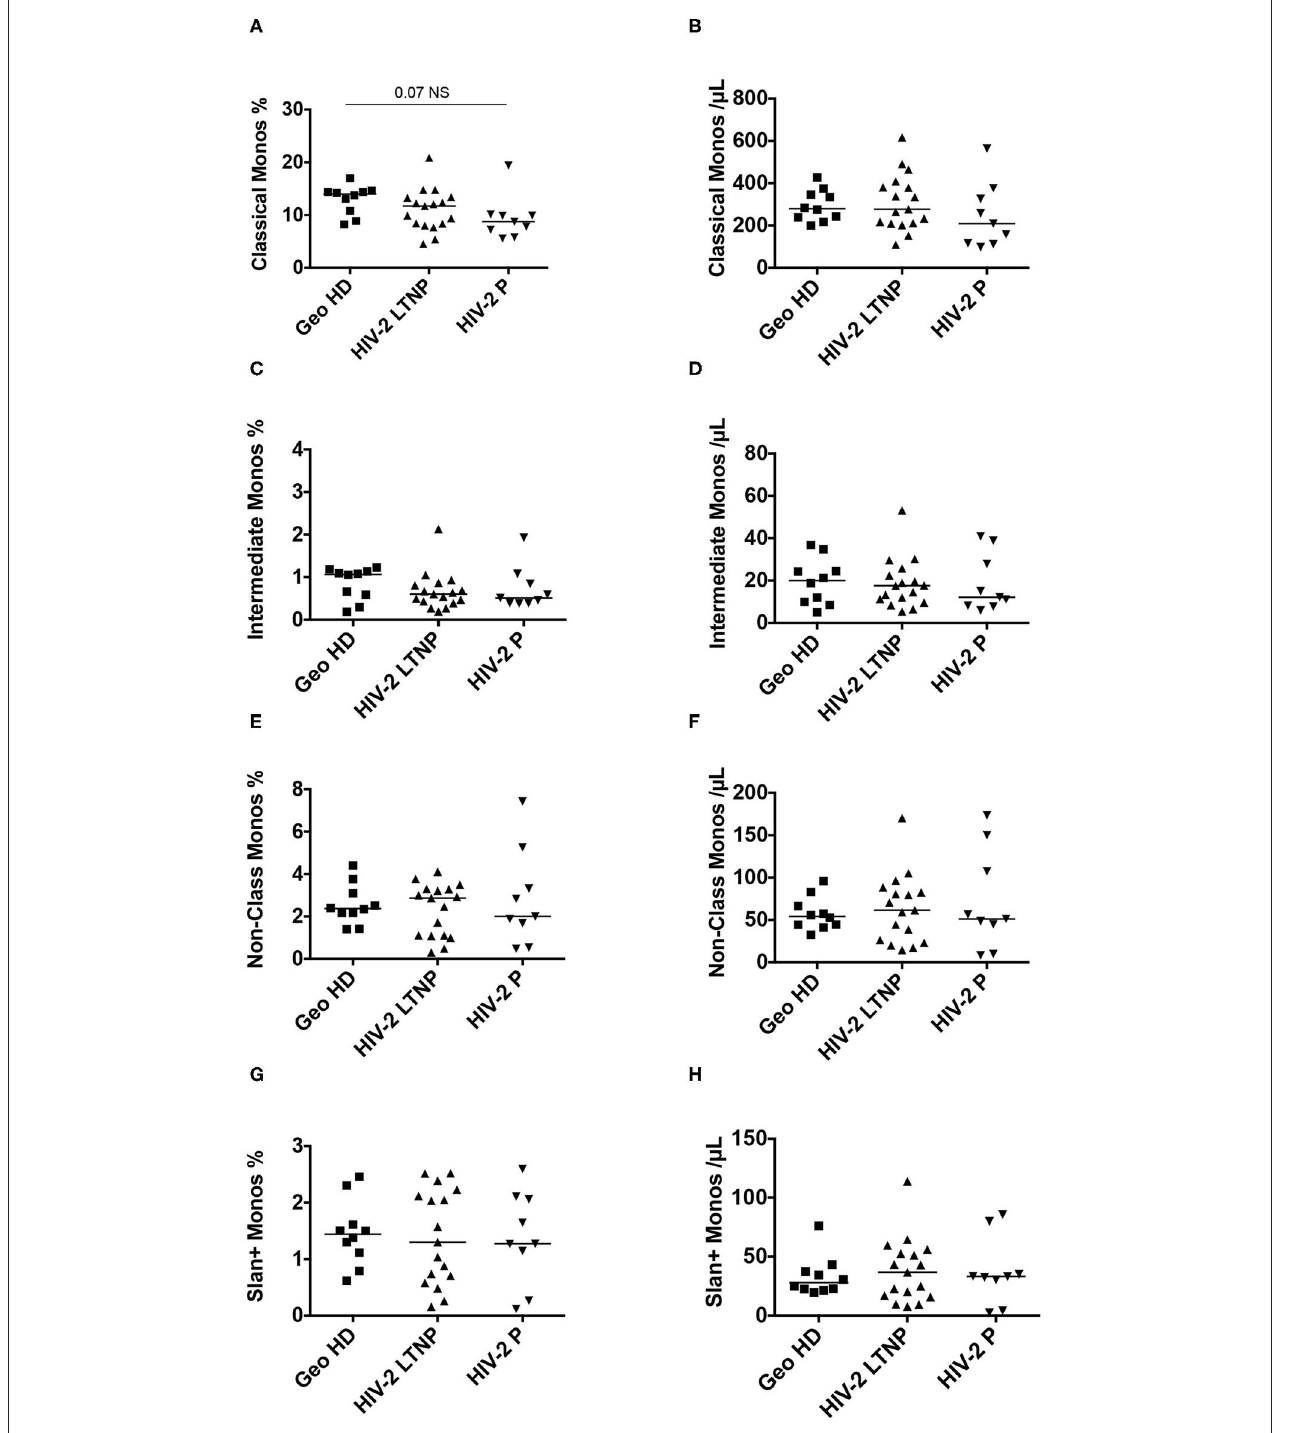
FIGURE 2 | Monocyte subset percentages among CD45 + PBMC and absolute counts in HIV-2-infected participants (LTNP and P) and uninfected controls (GeoHD), all of West African origin. (A) Classical monocyte (CD14 ++ CD16 − ) percentages among CD45 + PBMC and (B) absolute counts/ µ L blood, (C) intermediate monocyte CD14 + CD16 + percentages and (D) absolute counts/ µ L blood, (E) non-classical monocyte (CD14 ± C D16 + ) percentages and (F) absolute counts, (G) slan + monocyte percentages and (H) absolute counts, in GeoHD, HIV-2 LTNP and P groups, all of West-African origin. The data for the GeoHD group are the same as in Figure 1 Dunn’s post-test p is represented above the horizontal line connecting the compared groups. Horizontal bars represent median values. Kruskall-Wallis tests and descriptive statistics can be found in Table 2 , in italics .